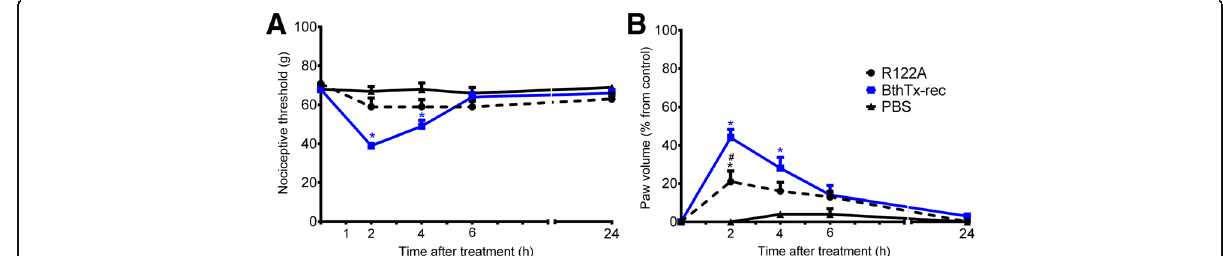
Fig. 4 Effect of BthTx-I K122A (Lys122 → Ala) mutagenesis on rat pain threshold and paw volume. Decrease in a threshold response and b paw volume were determined in rat hind paw before and 2, 4, 6 and 24 h after the intraplantar injection of PBS (control group) or R122A, or recombinant BthTx-I. Sensitivity to pain was measured as the threshold response to pressure and expressed as g . The paw volume was obtained pletsmografically. Each point represents the mean±SEM of six animals. *Significantly different from mean values before venom injection ( p< 0.05)